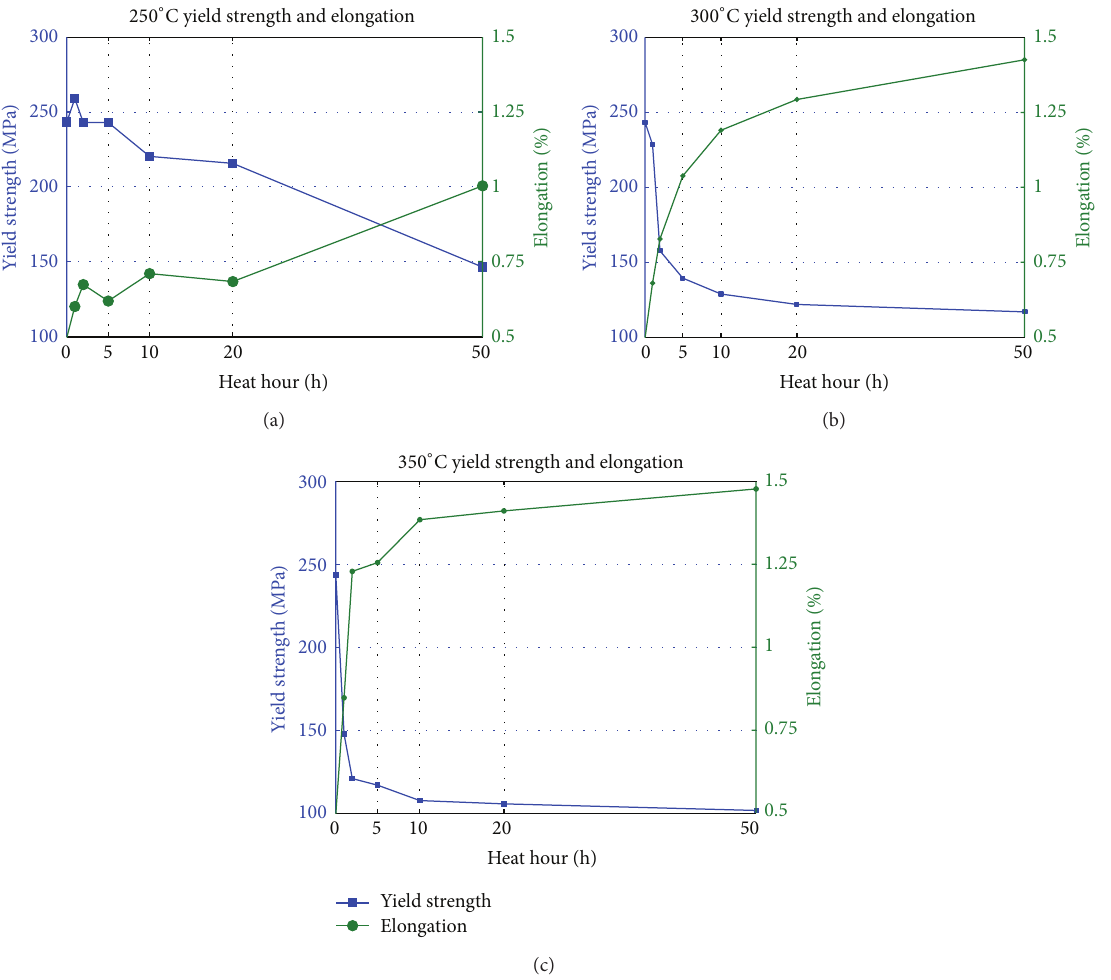
Figure 5: Yield strength and elongation obtained from the result of the tensile test for three heating temperatures: (a) 250 ∘ C, (b) 300 ∘ C, and (c) 350 ∘ C.